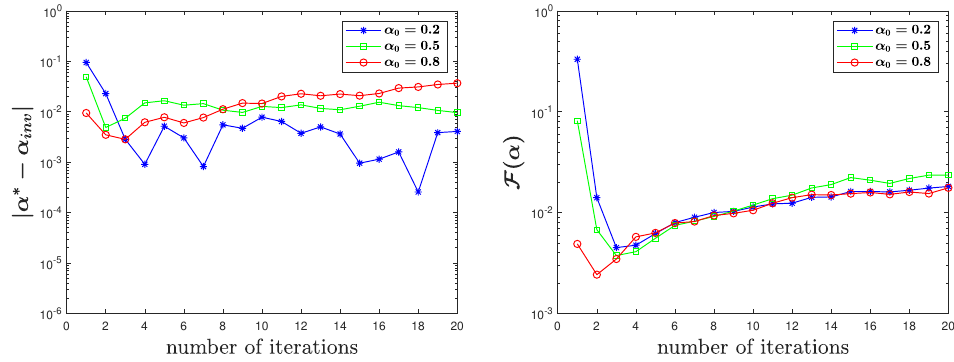
Figure 7. α ∗ = 0.75 for contaminated observation data with 1% of noise in Test